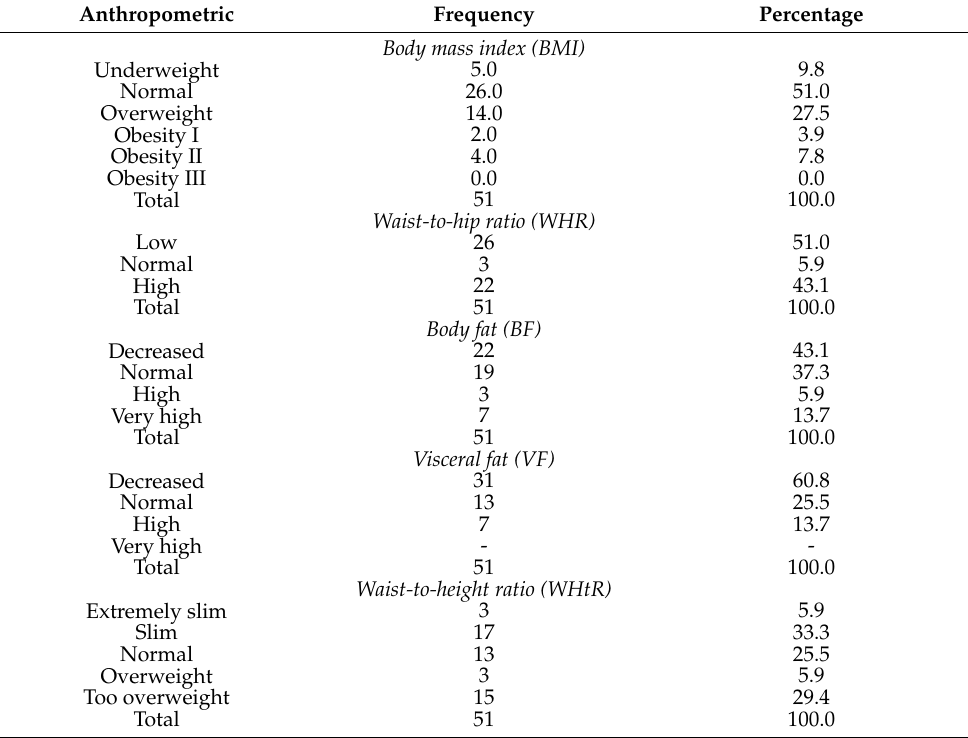
Table 4. Body mass index (BMI), waist-to-hip ratio (WHR), body fat (BF), visceral fat (VF), and waist-to-height ratio (WHtR) of females with CD ( n =